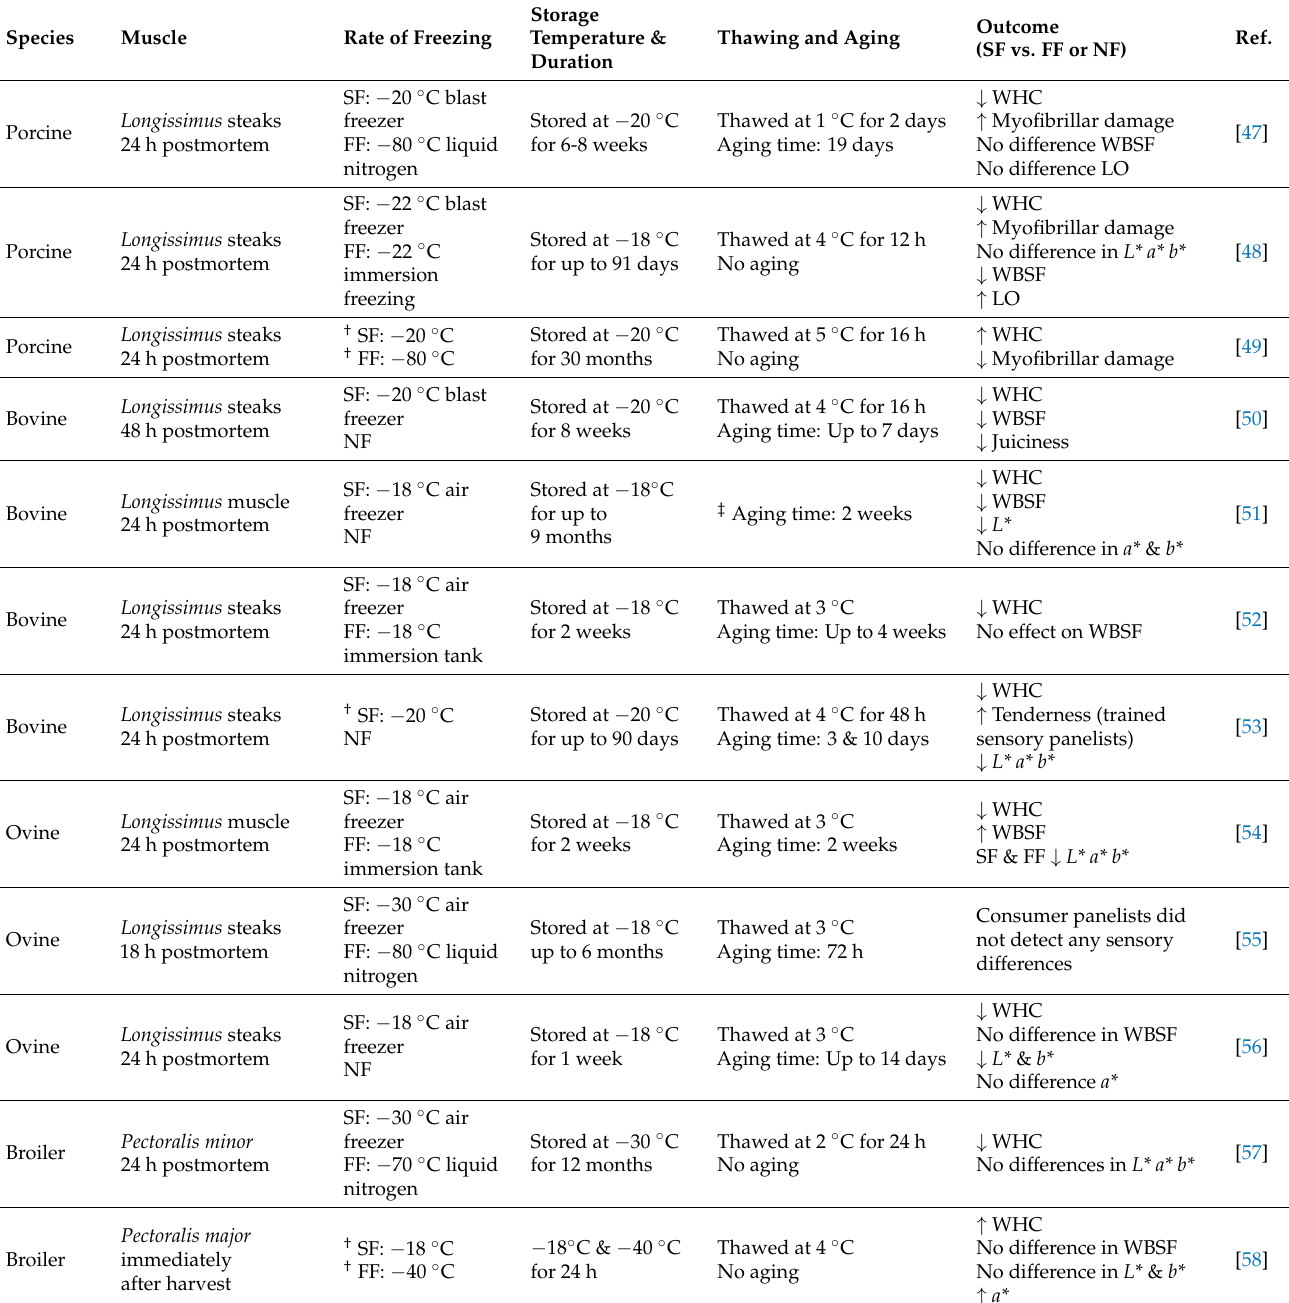
Table 1. Effects of freezing rates (slow vs. fast or never frozen) and thawing on meat quality. Species Muscle Rate of Freezing